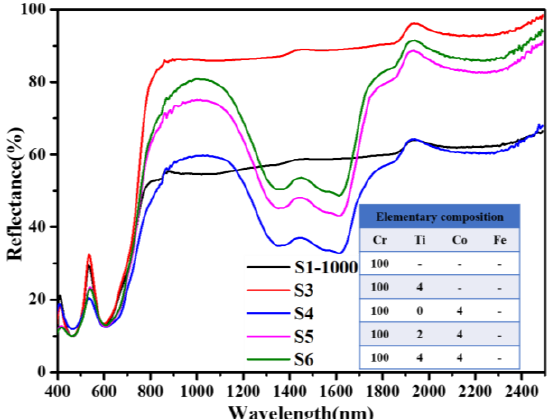
Figure 6. Influence of Co and Ti co-doping on diffuse reflectance spectra of Cr 2 O 3 samples.